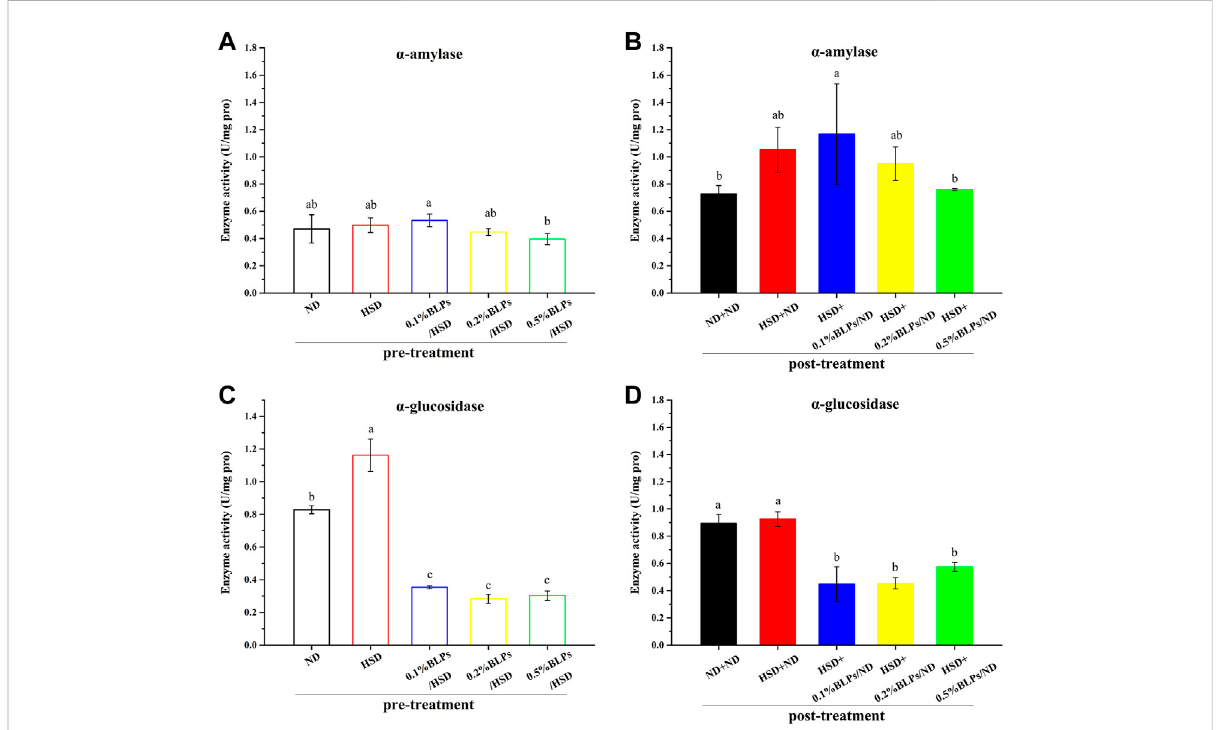
FIGURE 4 α -Amylaseactivity (A,B) and α -glucosidaseactivity (C,D) ofthose fl iesfedonadietcontainingBLPsatdifferentconcentrations inpre-treatment or post-treatment, respectively. Values with different letters (A – D) represent signi fi cant differences among the groups ( p <